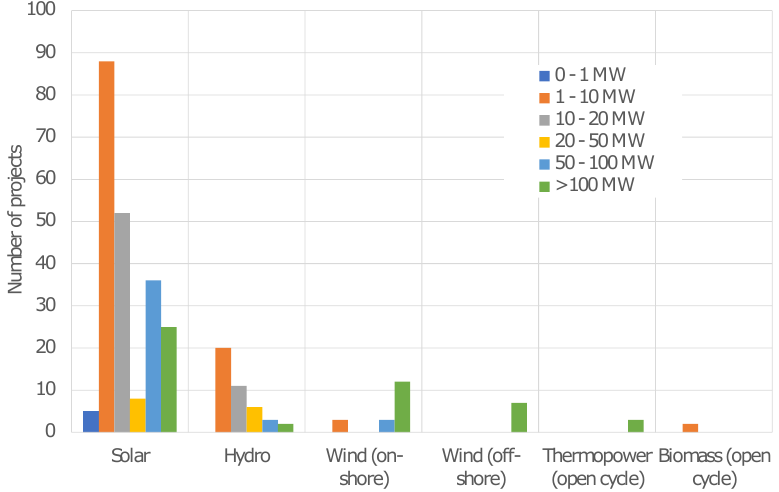
Figure 4. NCRES planned projects by capacity range with expected operation from 2023 in Colombia. Built with data from